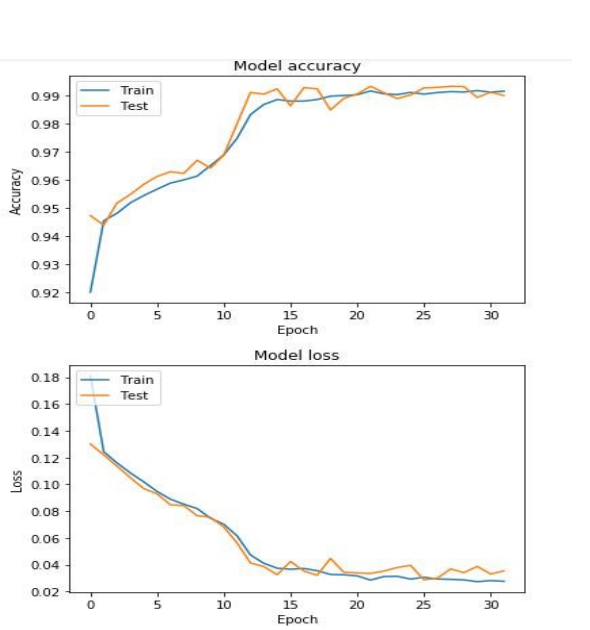
Fig. 5 Loss and Accuracy graph of 3-layer MLP